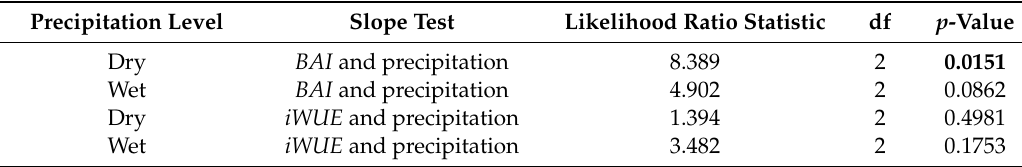
Figure A2. Relationships of 10-year moving average data of the relatively dry and wet years over the past 61 years between ( a , b ) basal area increment ( BAI ) and precipitation ( n = 27, 28, and 27), and ( c , d ) intrinsic water use efficiency ( iWUE ) and precipitation ( n = 3, 3 and 3), for low, medium and high competition-level trees, using standardized major axis (SMA) regression. Table A1. Slope tests of the SMA regressions shown in Figure A2.